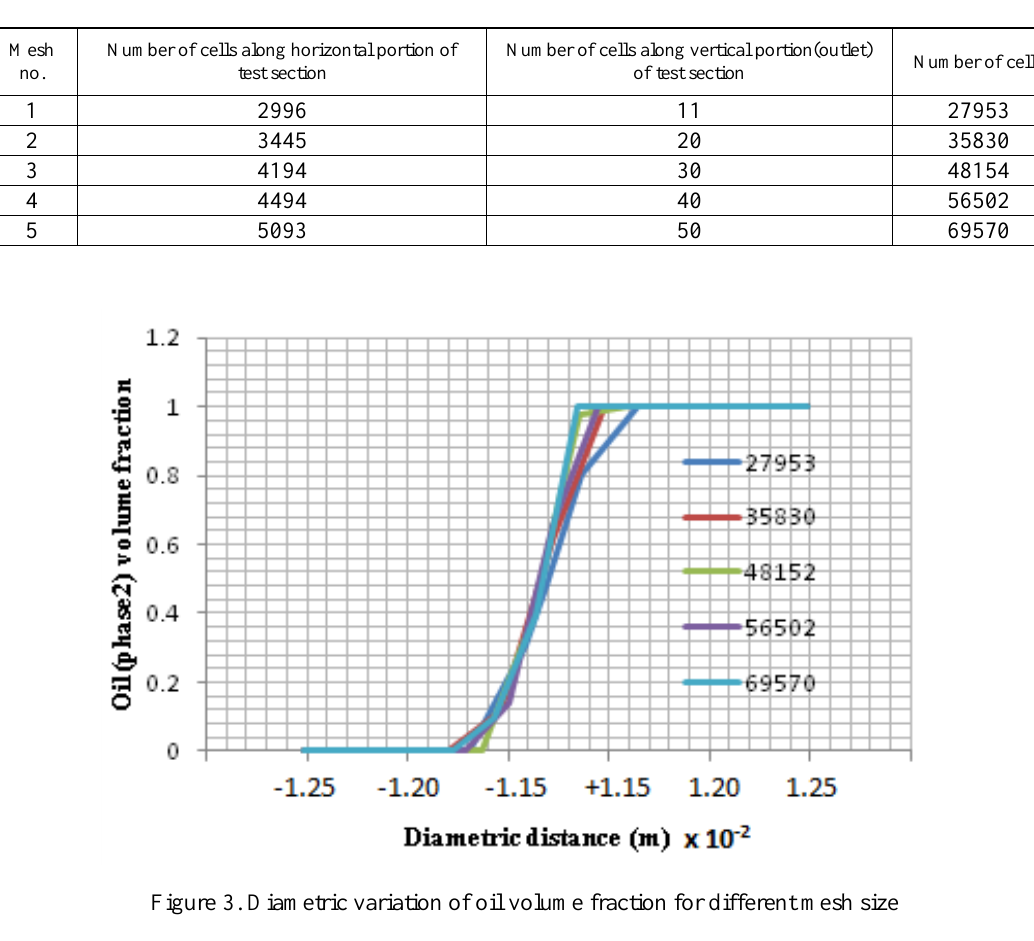
Table 2. Details of different grids used in mesh independent study